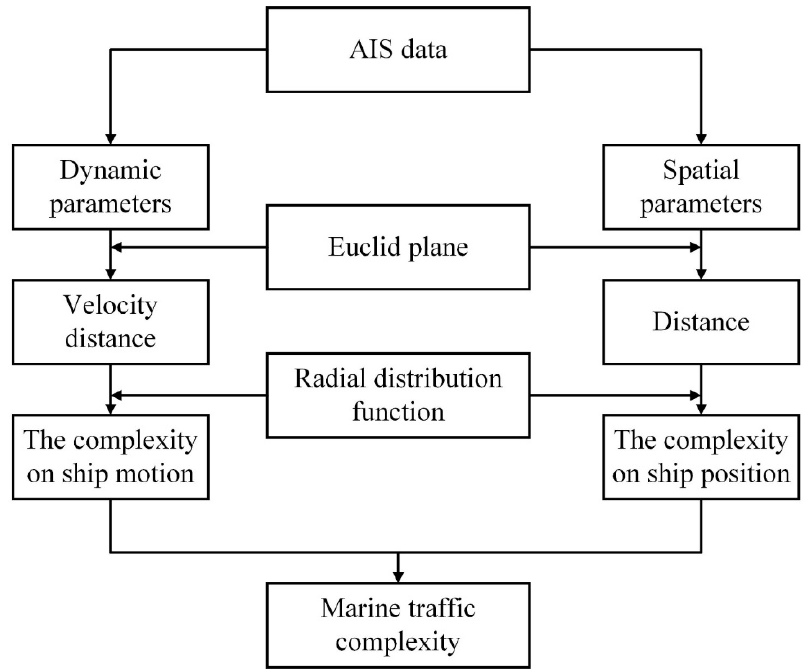
Figure 5. The flow chart of the proposed